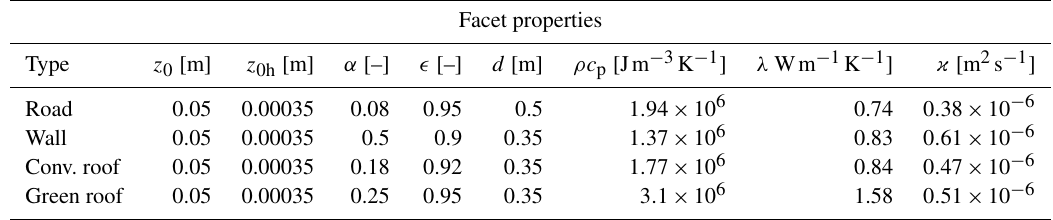
Table 5. Facet properties for the Eastside demo target